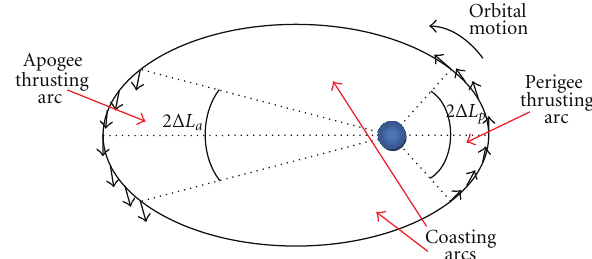
Figure 6: Thrusting arcs around apogee and